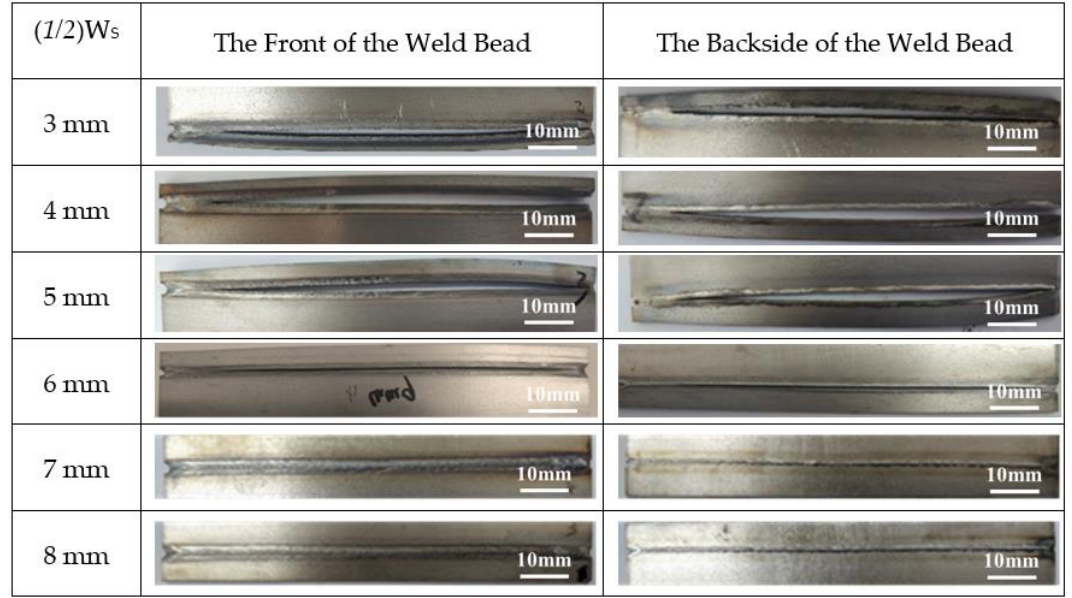
Figure 4. The macro profile of the solidification cracking of SUS310 stainless steel under the different values of ( 1/2 )W S during laser welding at a welding speed of 1.0 m/min.